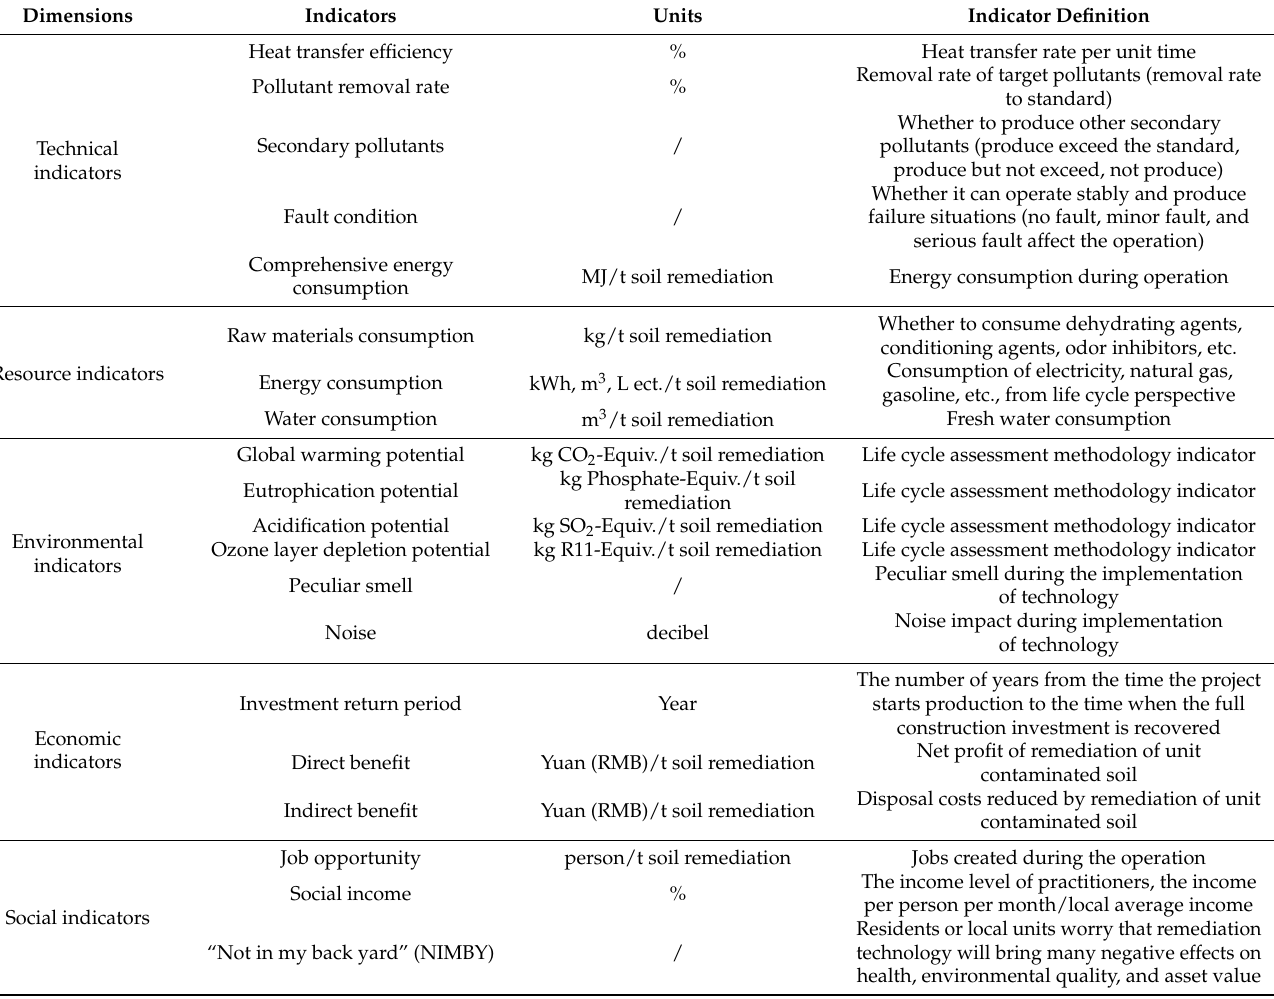
Table 1. Comprehensive evaluation indicators of ex situ thermal desorption remediation